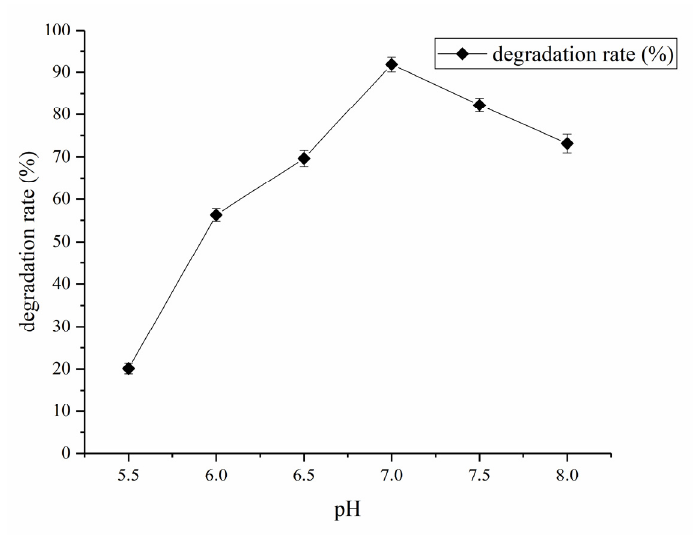
Figure 11. Effect of different pH values on the degradation rate of coumarin. The results are expressed as the mean ± SD from three independent experiments.